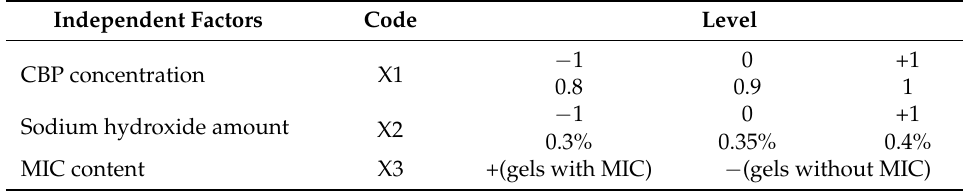
Table 2. Independent parameters.